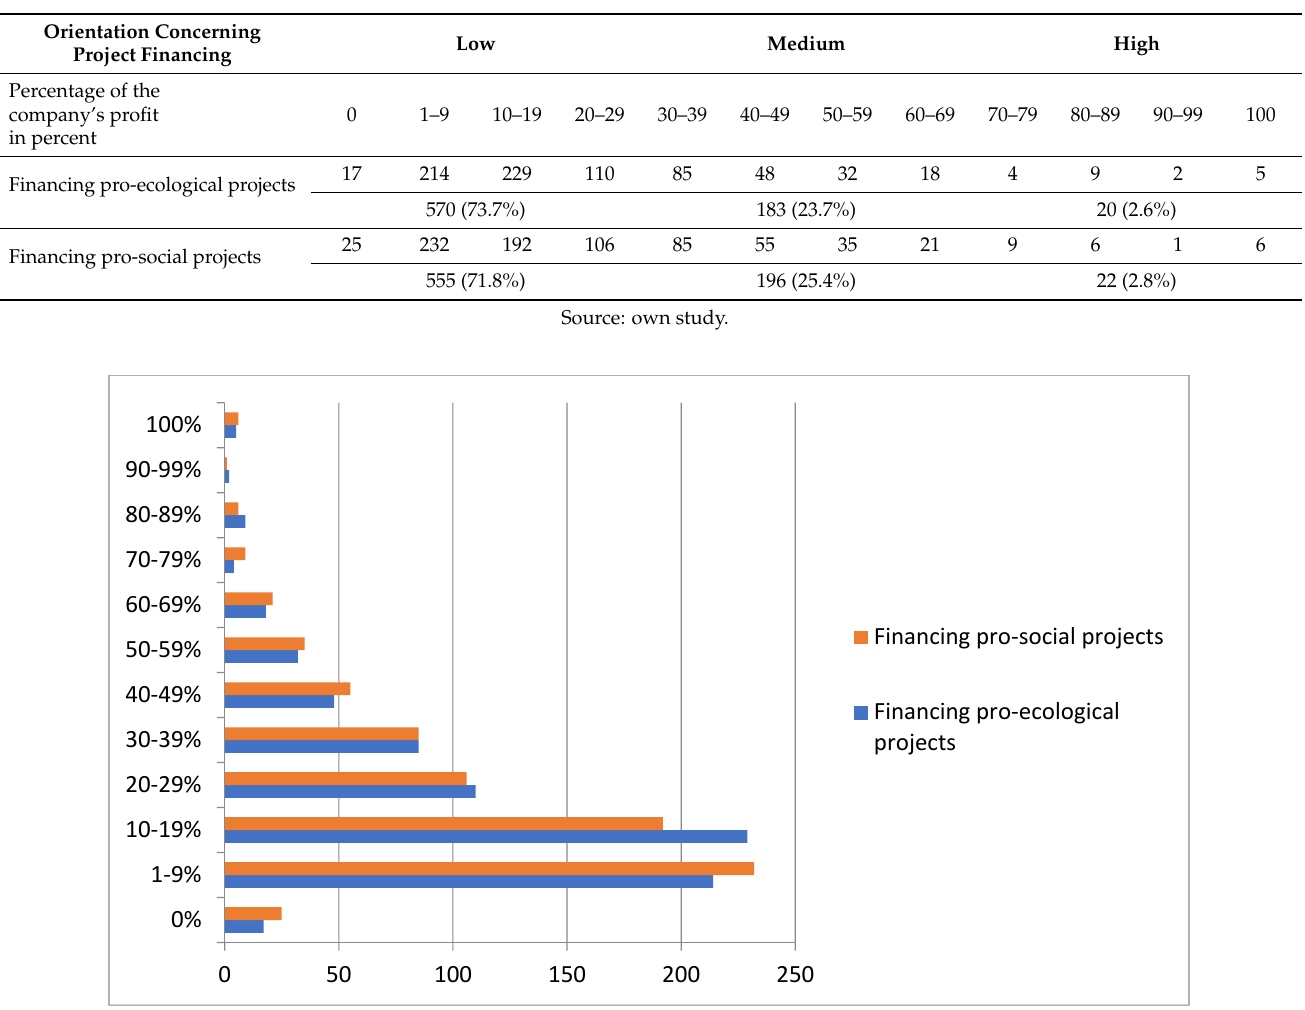
Figure 2. The percentage of the company’s profit declared by the younger generation to be allocated to financing pro- ecological and pro-social projects. Source: own study (based on Table 2).